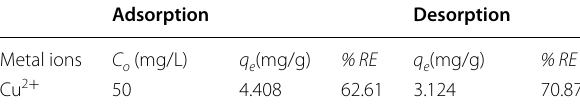
Table 6 Regeneration and desorption data of copper onto MNA-7 h